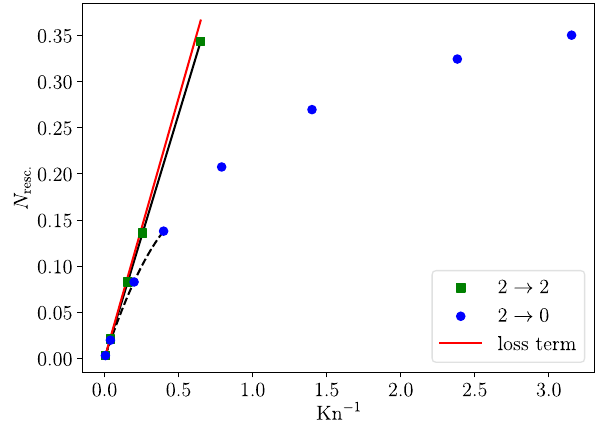
Fig. 1 Mean number of rescatterings per particle over the system evolution as a function of the inverse Knudsen number estimated in the initial state, Eq. (12), for the 2 → 2 (green squares, fit with N resc . ≈ 0 . 529Kn − 1 ) and 2 → 0 (blue circles, fitted with a quadratic ansatz: dashed line) scenarios. The red line N resc . = Kn − 1 / prediction of the analytical